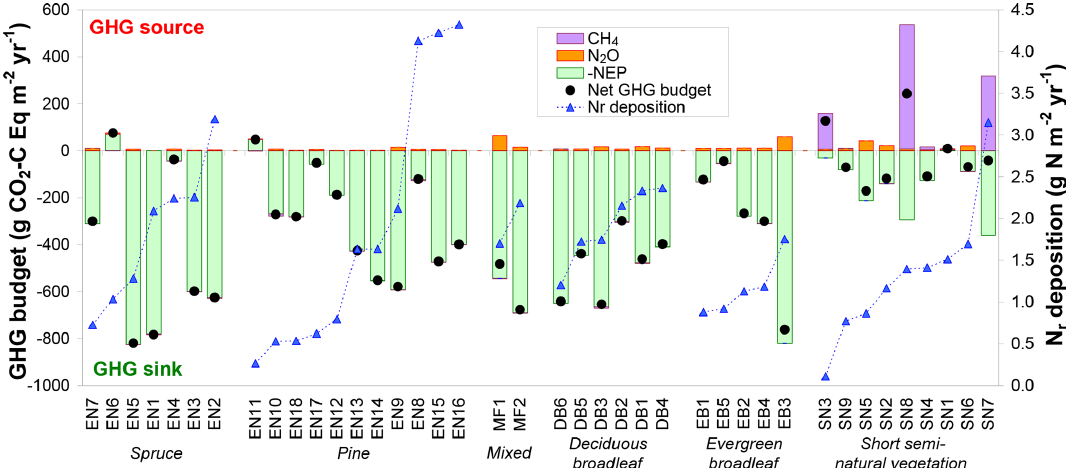
Figure 7. Net greenhouse gas (GHG) budgets calculated from a combination of inter-annual mean (around 2005–2010) net ecosystem productivity (NEP) from eddy covariance, and N 2 O and CH 4 flux data measured in situ or estimated by extrapolated bioassay data and forest ecosystem BASFOR modelling. Global warming potential values (100-year time horizon) of 265 and 28 were used for N 2 O and CH 4 , respectively; the sign convention is with respect to the atmosphere: negative for a sink and positive for a source. The data were grouped by ecosystem type (evergreen needleleaf: EN-spruce and EN-pine; MF: mixed forests; DB: deciduous broadleaf; EB: evergreen broadleaf; SN: short semi-natural vegetation); within each group the data were sorted by increasing N r